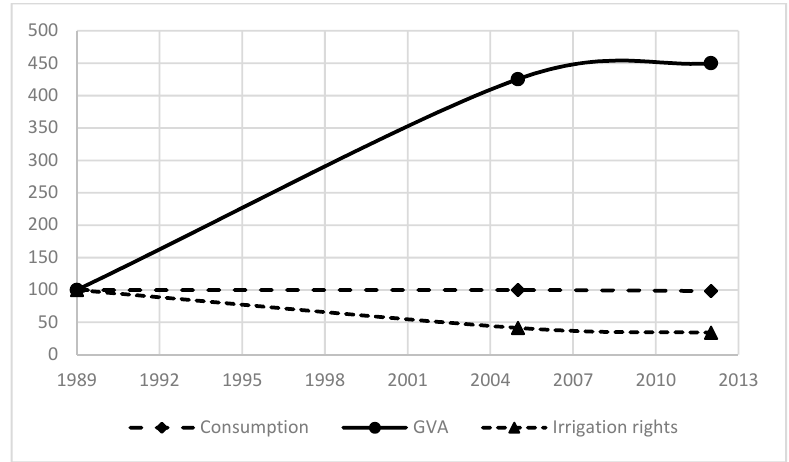
Figure 3. Indexes of water consumption, irrigation rights and GVA. Note: Base year 1989 = 100.